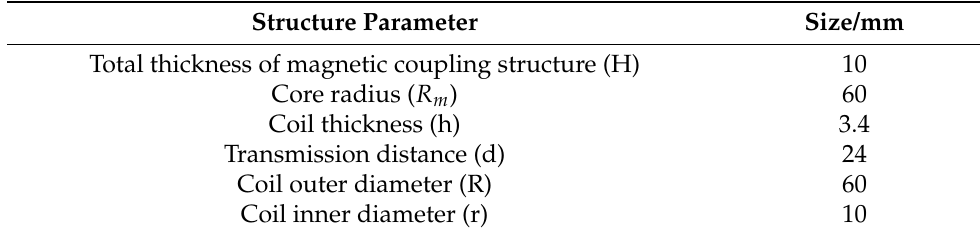
Table 4. Structural parameters of the planar core.